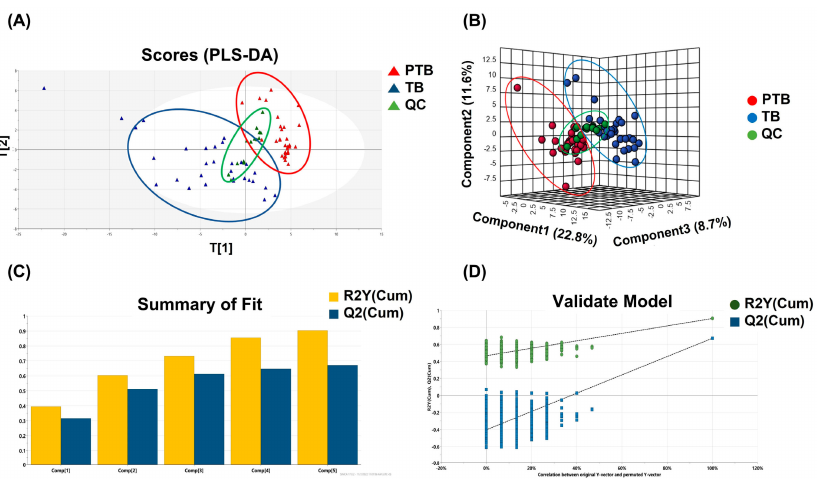
Figure 2. Multivariate statistical analysis. ( A ) PLS-DA score plot and ( B ) 3D PLS-DA score plot of the whole lipidome data between PTB and TB containing QC. ( C ) PLS-DA model revealed the robustness of itself and ( D ) thousand-time permutation